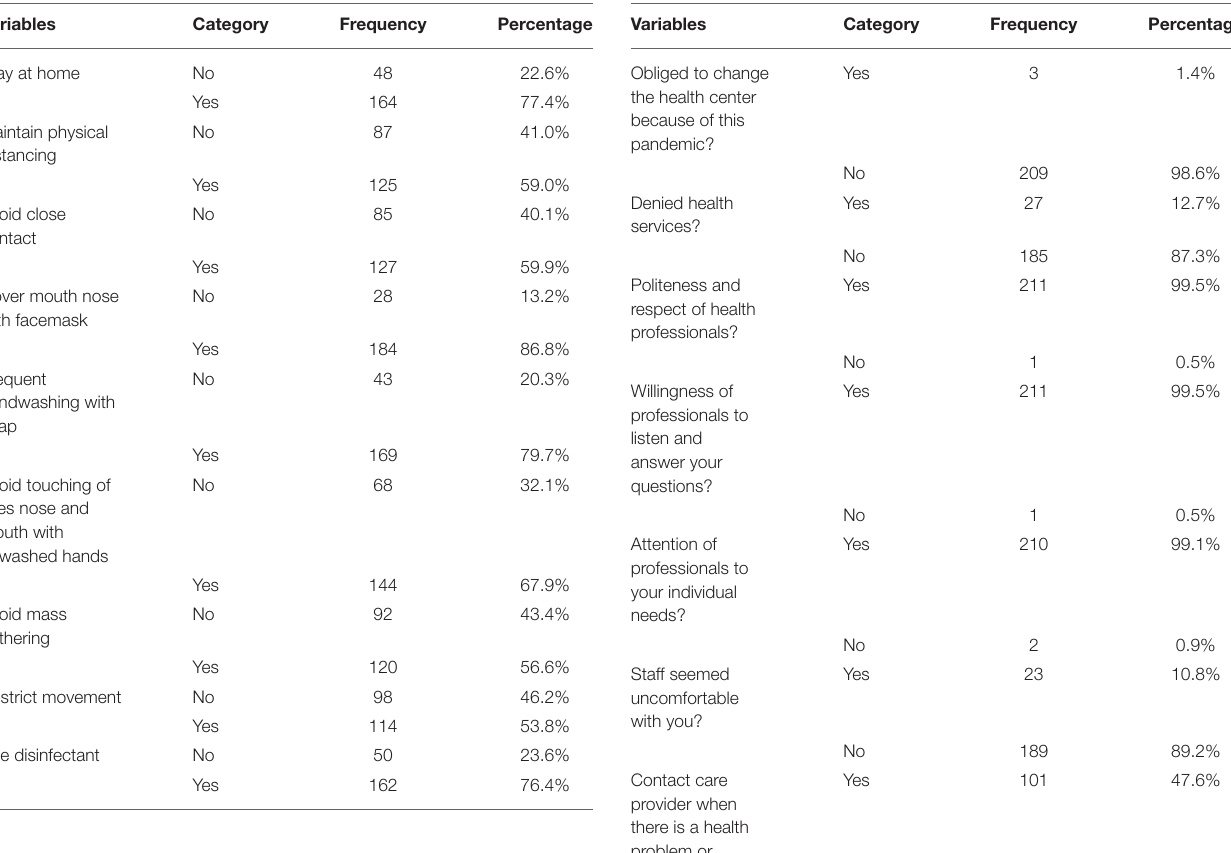
TABLE 3 | Awareness of respondents on COVID-19 preventive measure, Addis Ababa, Ethiopia, May 2021.